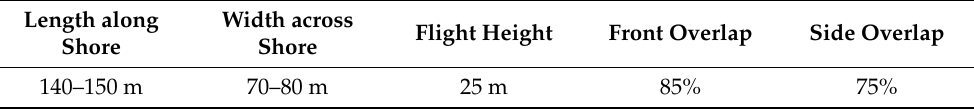
Table 1. Geometrical properties for the coral reef on Fuvahmulah Island measurement site. Length along